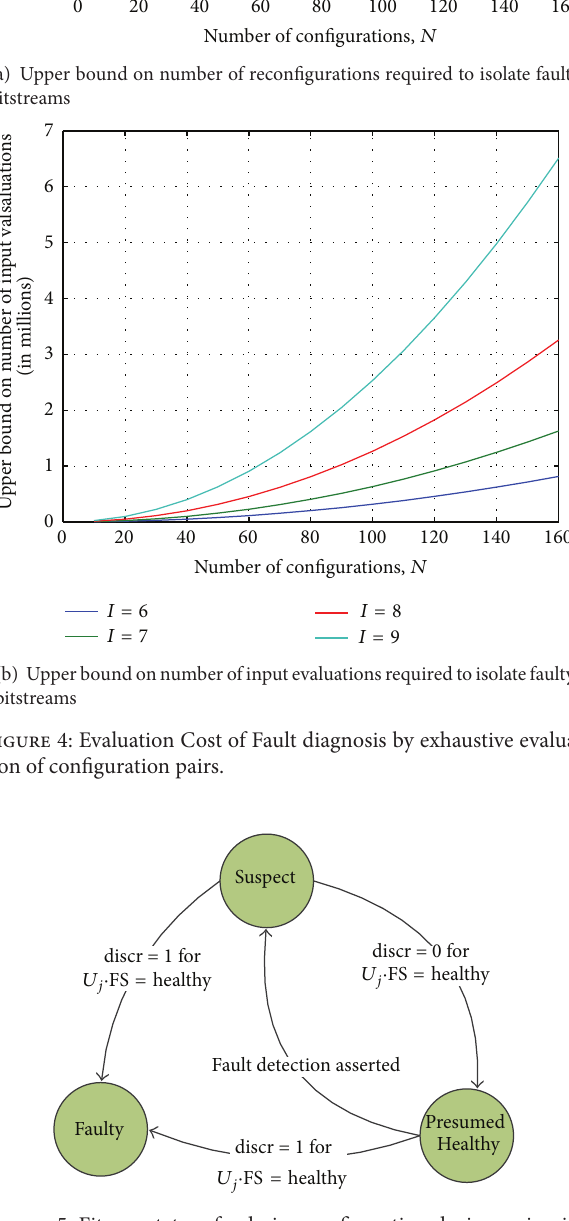
Figure 5: Fitness states of a design configuration during a circuit’s lifetime.